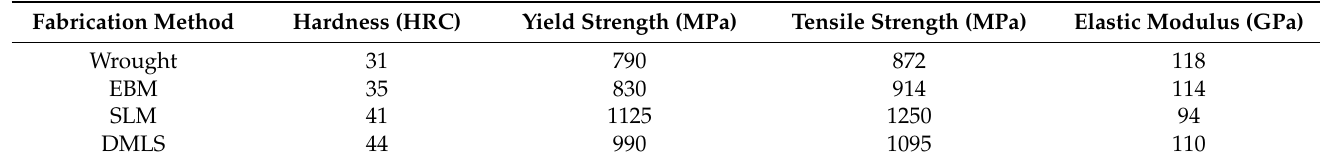
Table 1. Mechanical properties of titanium alloy Ti6Al4V fabricated by different methods, data from